Question: Summarize what this figure shows in one sentence.
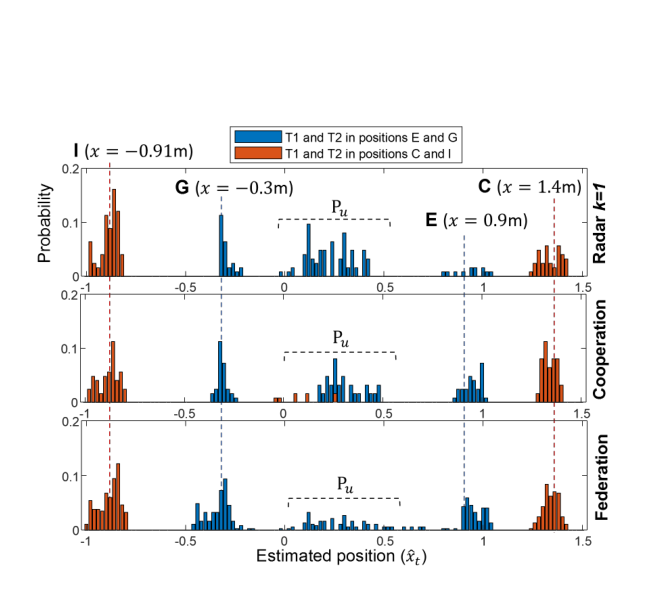
Answer: Probability distribution of estimated positions bxt for targets T1, T2 located in C, I (red bars) moving to G, E (blue bars). Pu is the probability of unresolved targets. Cooperation, federation and isolated (k = 1) cases are compared.